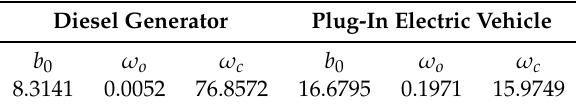
Table 4. Parameters of the distributed control strategy (DCS)-ILADRC used for the